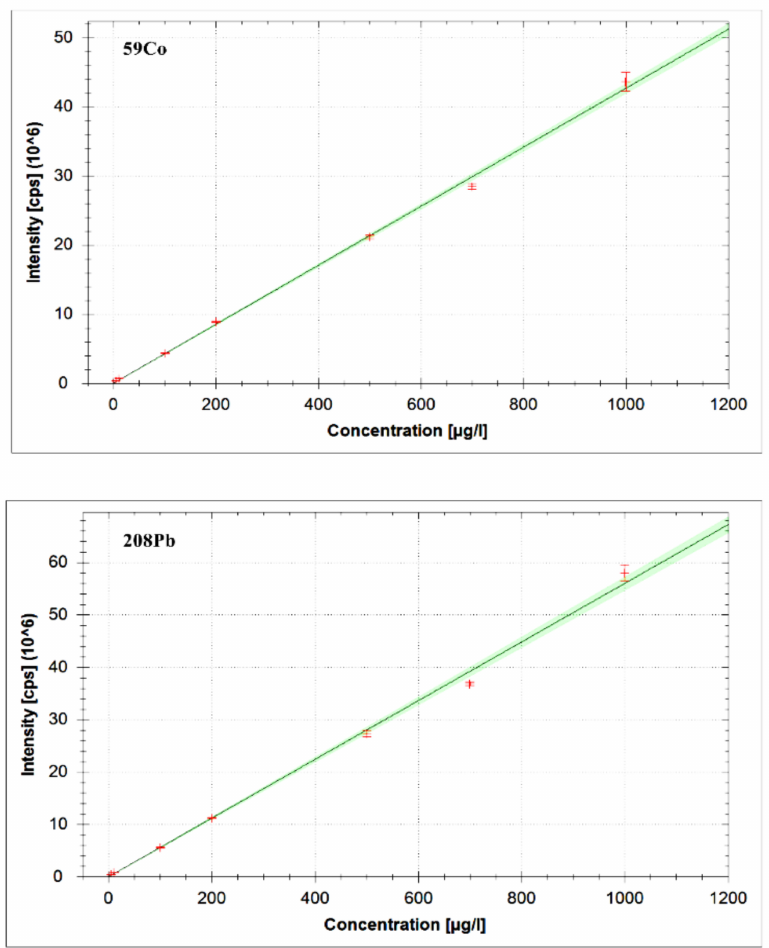
Figure 2. Calibration curves of some of the heavy metals (Co and Pb) obtained using iCAPQ ICP-MS